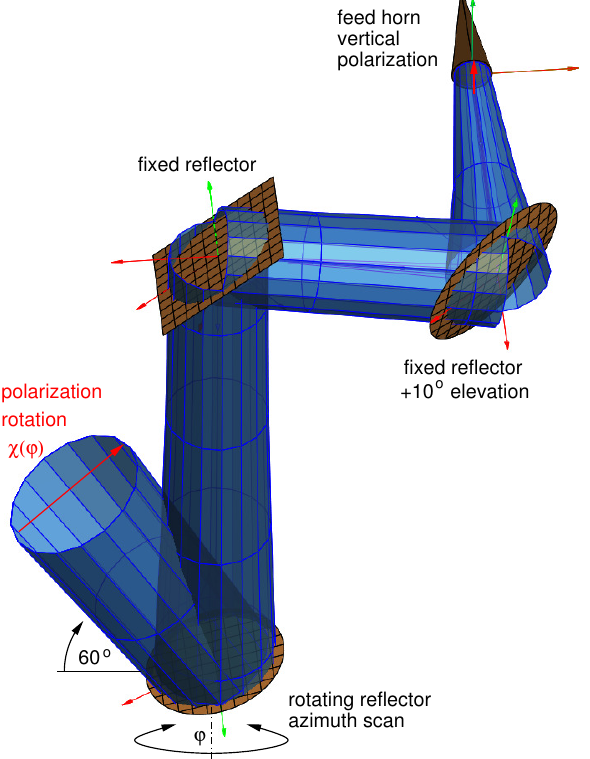
Figure 7. Simulation of the propagation of a vertical electric field from the TEMPERA antenna to the atmosphere and passing through the different mirrors using the GRASP package software.